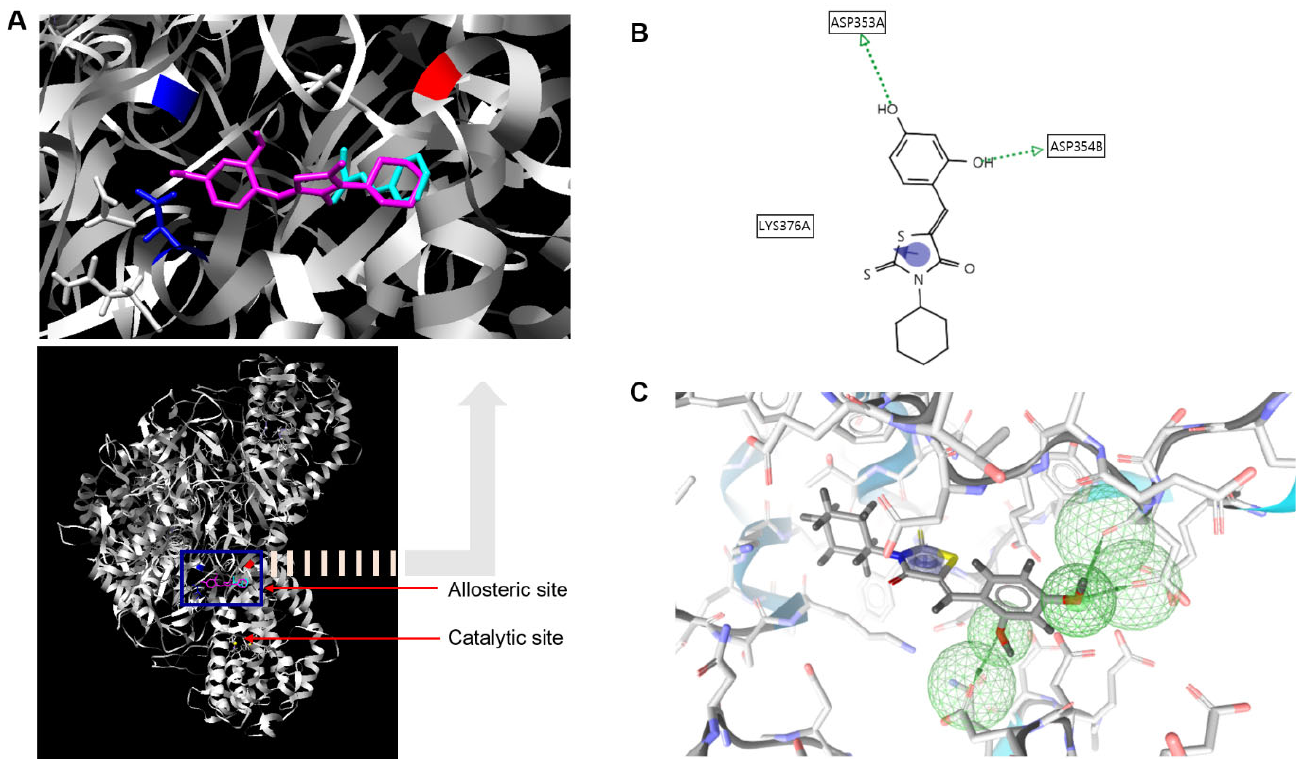
Figure 3. Docking simulation of analog 3 with mushroom tyrosinase (PDB ID: 2Y9X) as determined using AutoDock Vina. Bindings of 3 (magenta) and cinnamic acid (cyan) to the allosteric site of tyrosinase ( A ). Interactions between analog 3 and tyrosinase are shown in 2D ( B ) and 3D ( C ). Aspartic acid and lysine residues that interact with 3 are represented in blue and red ( A ). Green arrows represent hydrogen bonds ( C ).